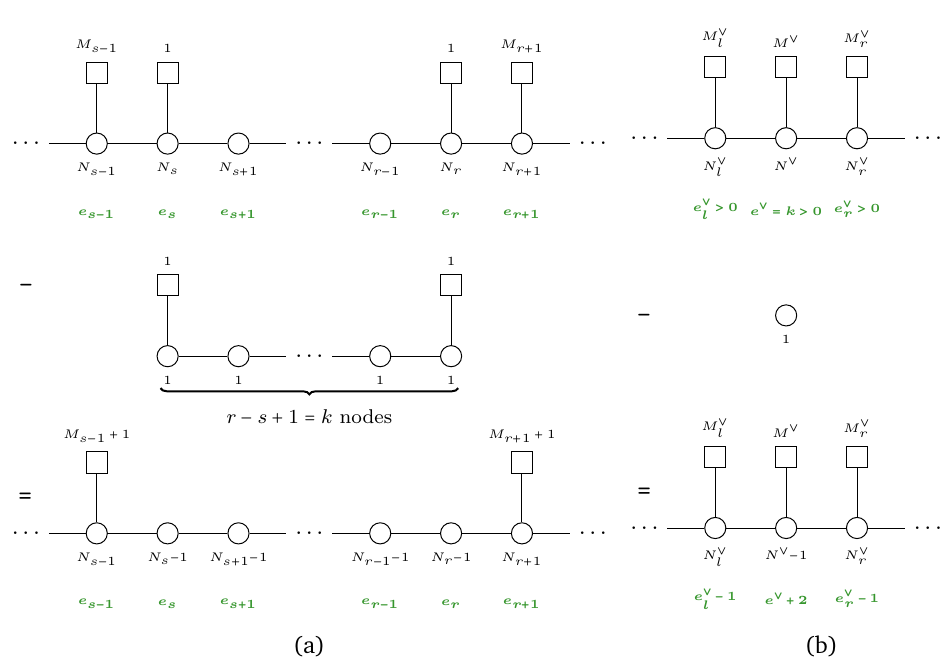
Figure 10: a: The A transition on the Higgs branch is realised by subtracting the k quiver of [ 1 ] − ( 1 ) − ... − ( 1 ) − [ 1 ] with k U ( 1 ) gauge factors and adjusting the flavour nodes such that the balance e is preserved. b: In the mirror, the exists a i node with balance e ∨ = k surrounded by node with strictly positive balance. The Coulomb branch transition is realised by subtracting a finite A Dynkin 1